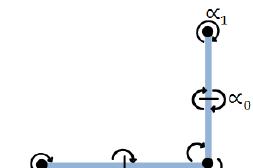
Figure 1 . Example of two darts tied together and formed an edge, is a subdivision of n-dimensional space and represents darts in a model.